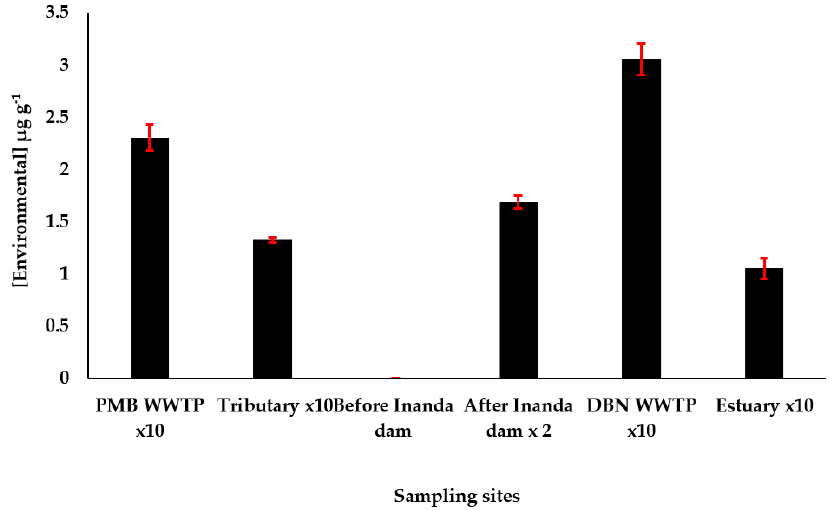
Figure 6. Environmental sediment samples analysis using developed analytical method.